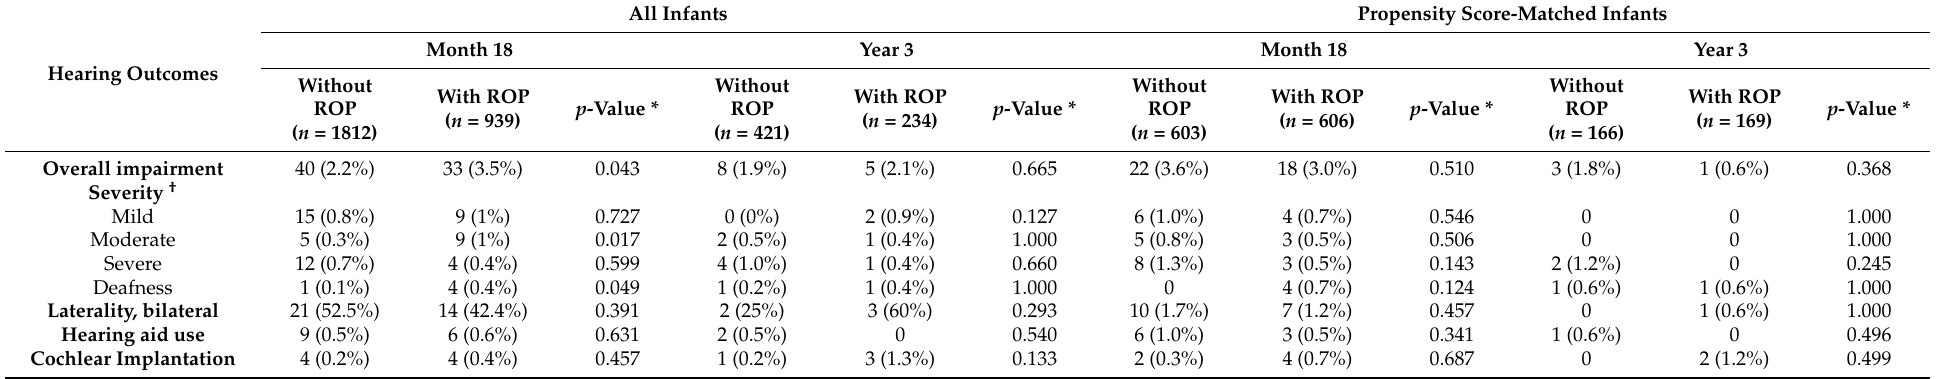
Table 2. Hearing impairment in infants with and without retinopathy of prematurity (ROP) at 18 months (first follow-up) and 3 years of age (second